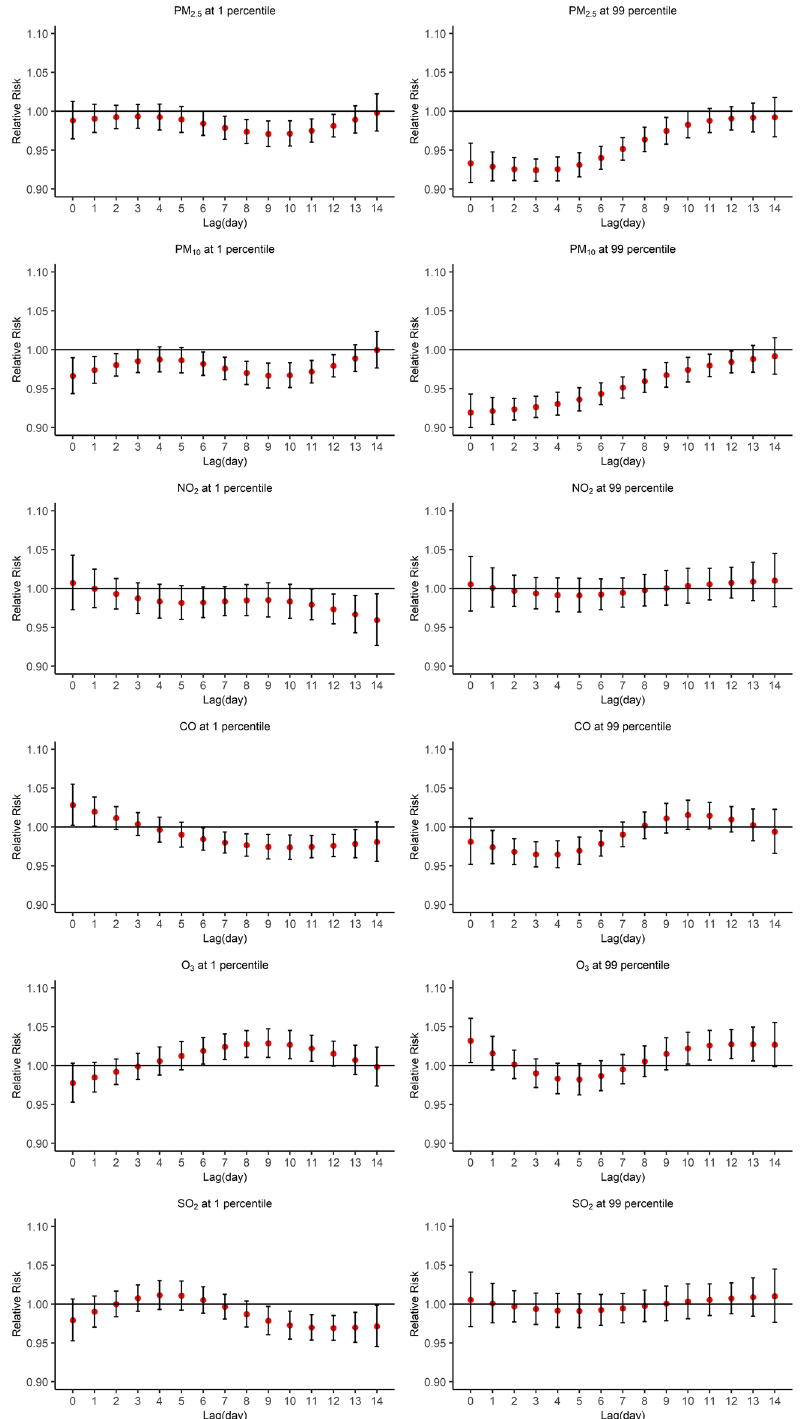
Figure 3. Associations between air pollutants at the 1st (left) and 99th (right) percentiles and HFMD across lag